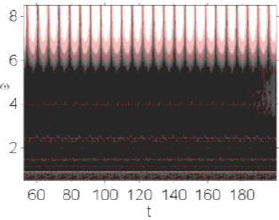
Fig. 6. Wavelet spectrum in interval of 52 t 200, s 0 = 18.7, ω p = 8.7.